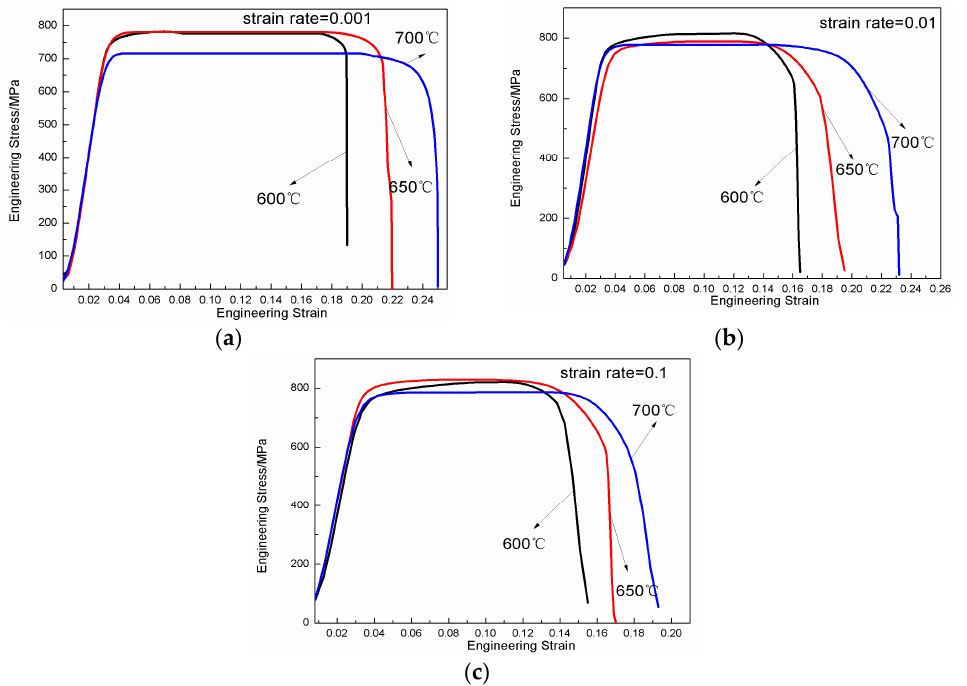
Figure 6. Engineering stress-engineering strain curves of the tensile samples at different temperatures and strain rates. (The initial dimensions of the high temperature tensile specimens were 1.5 mm in thickness, 3 mm in width and 10 mm in a gauge length. To minimize oxidation, the gauge section of each specimen was coated with glass slurry. To preserve the microstructure under testing temperature conditions, the specimens were rapidly water quenched.), ( a ) 0.001 s − 1 , ( b ) 0.01 s − 1 , ( c ) 0.1 s − 1 .